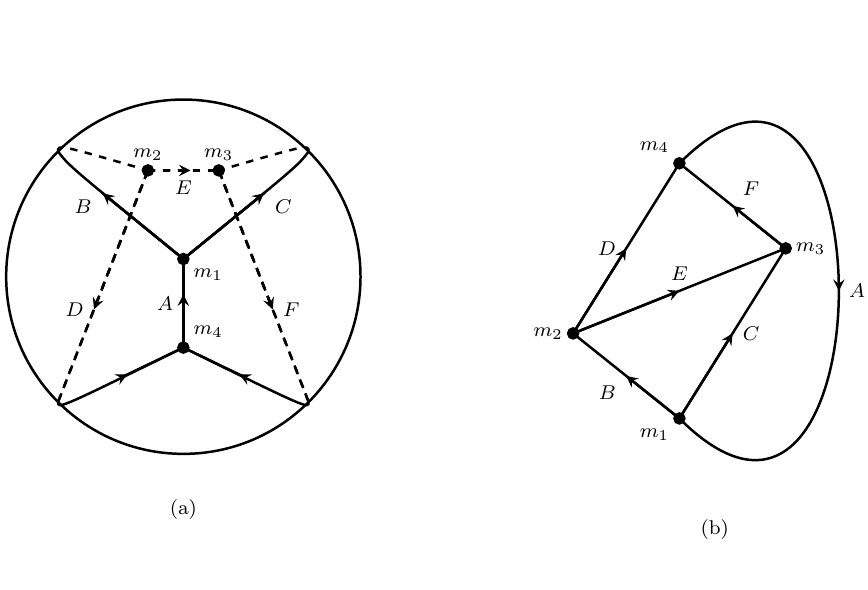
Figure 10 . (a) A graph (cid:0) of boundary line defects drawn on a sphere. (b) The same graph drawn on a plane obtained after removing a point from the